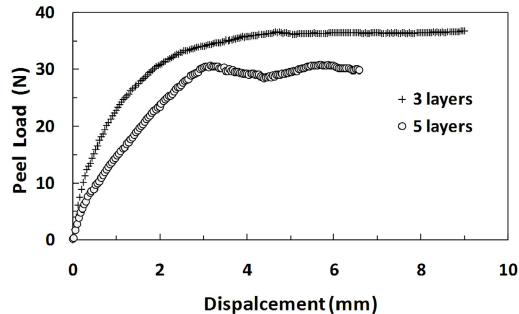
Figure 9. Load versus displacement curve for the 5 layers and 3 layers of the sandwich composites obtained from peel test (at the same rolling conditions).